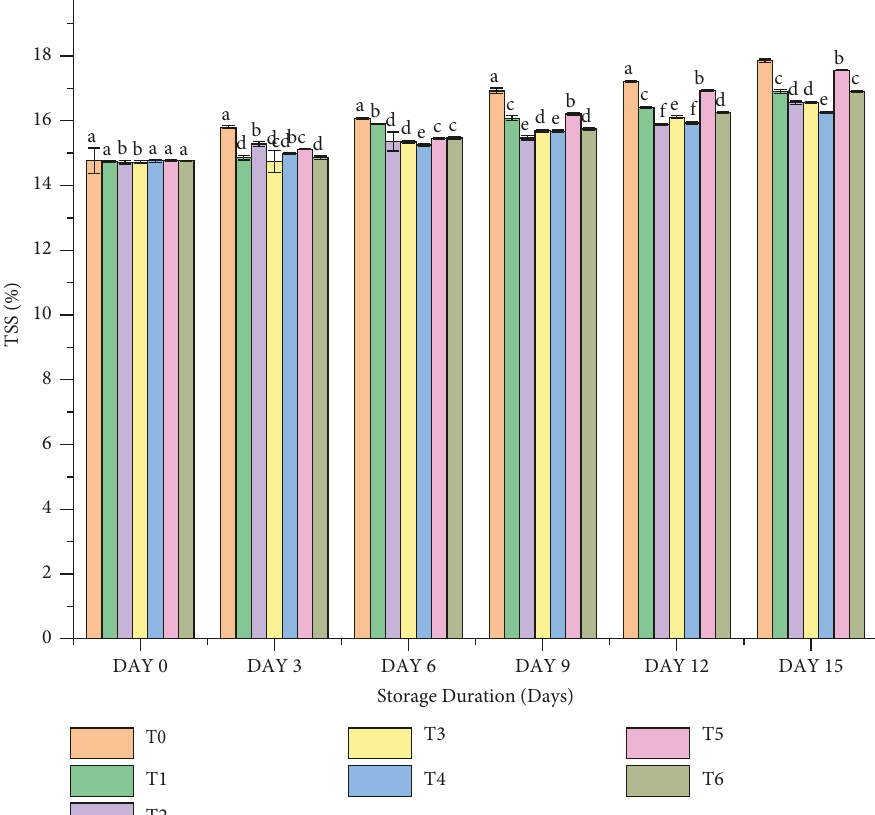
Figure 5: Effect of chitosan coating and cinnamon essential oil on total soluble solids (TSS) of pomegranate arils during storage at 4 ± 1 ° C. Vertical bars represent the mean ± SD of 3 replicates. Error bars with different letters on the same storage period show a significant difference ( P ≤ 0 . 05). T0 � control; T1 � 1% chitosan+0.25% oil; T2 � 1% chitosan+0.5% oil; T3 � 2% chitosan+0.25% oil; T4 � 2% chitosan+0.5%